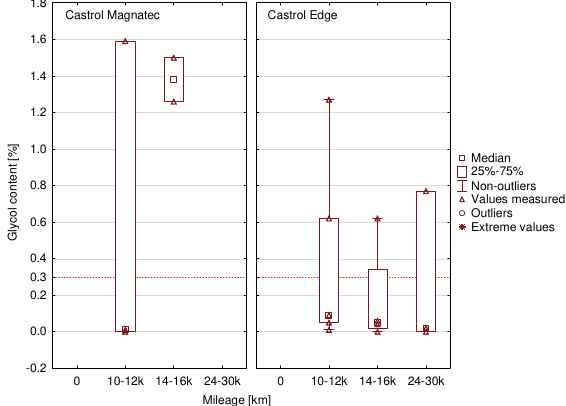
Fig. 9. The glycol content of the engine oils